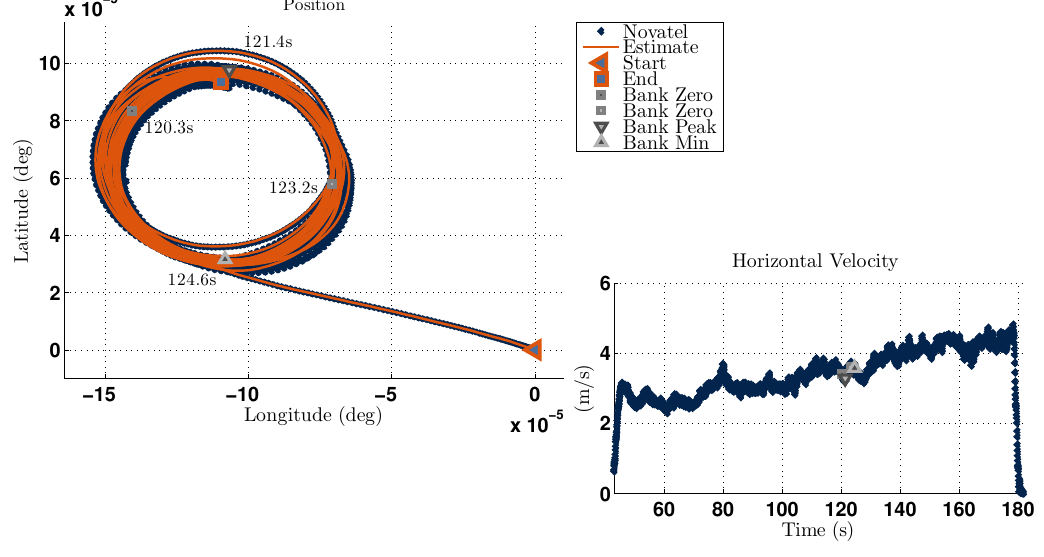
Figure 15. Coupled EKF on the NCAT skid pad 10-ft circle position and